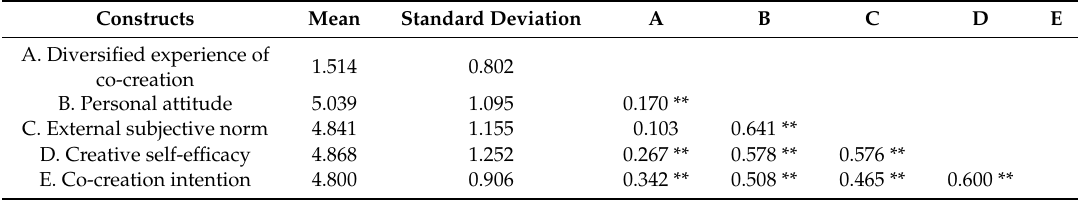
Table 2. Means, standard deviations and correlations of the constructs.